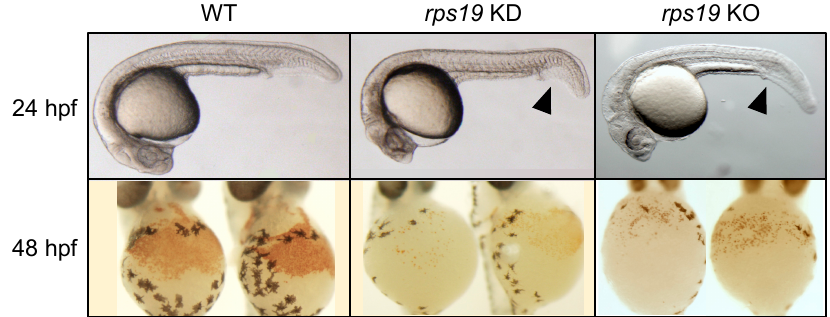
Figure 1. Zebrafish DBA models. Wild-type embryos show a high density of red blood cells (WT), whereas the blood production is drastically reduced in the rps19 knockdown (KD) and knockout (KO) embryos, as indicated by the absence of hemoglobin stained cells (lower panels). These embryos also display developmental deformities in head and tail regions (arrowheads). The abnormal phenotypes were rescued by injection of rps19 mRNA but not rescued by mRNA with patient type mutations in the knockdown embryos [14].